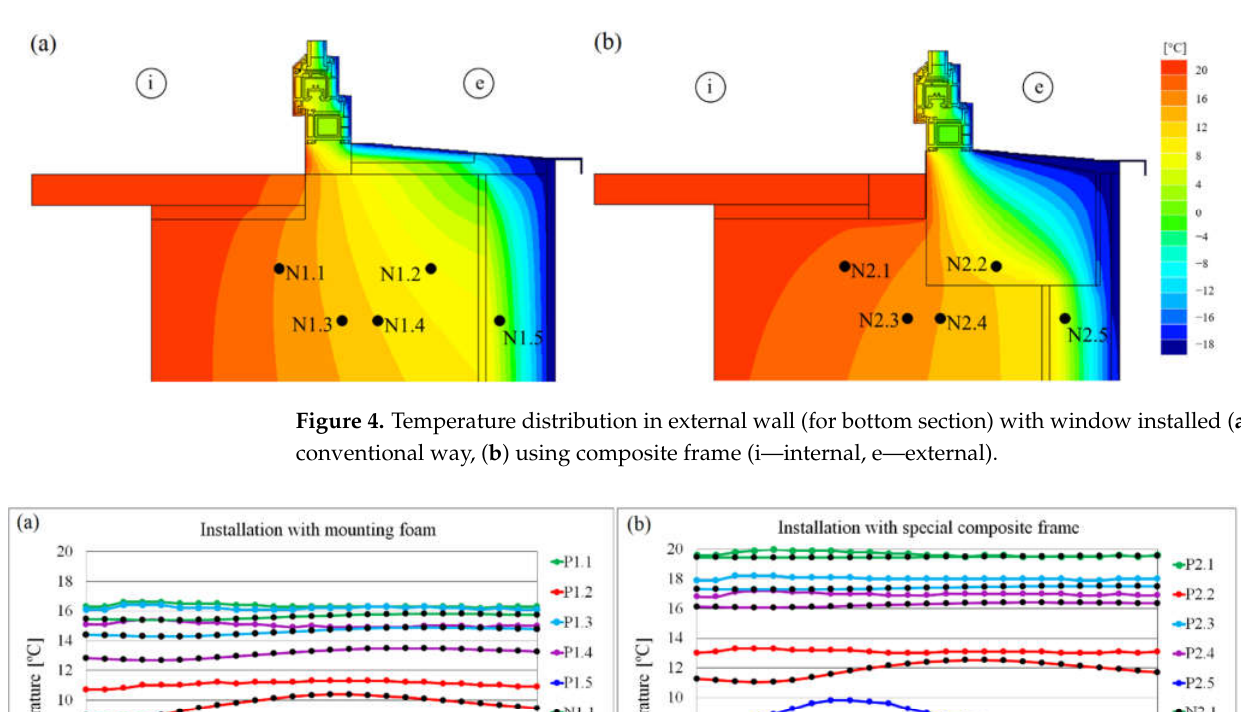
Figure 4. Temperature distribution in external wall (for bottom section) with window installed ( a ) in conventional way, ( b ) using composite frame (i—internal, e—external).